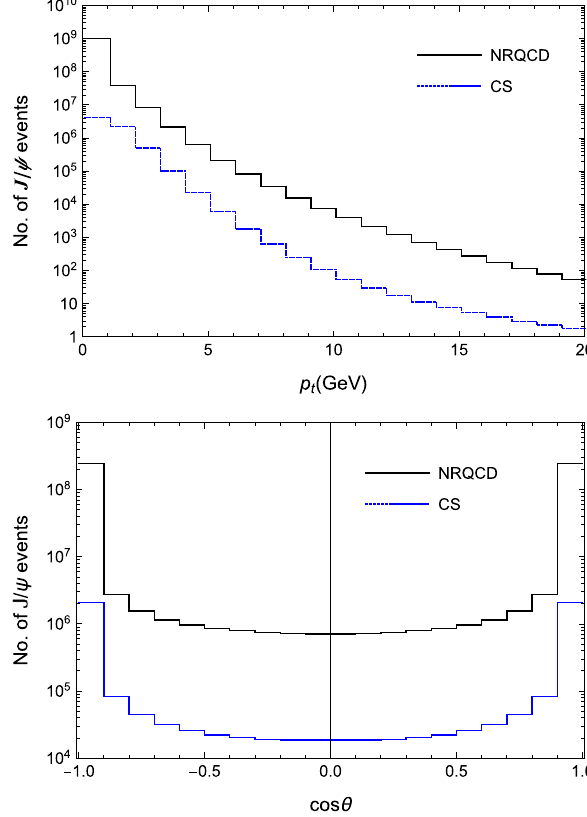
Fig. 4 The p t and cos θ distributions of the number of J /ψ